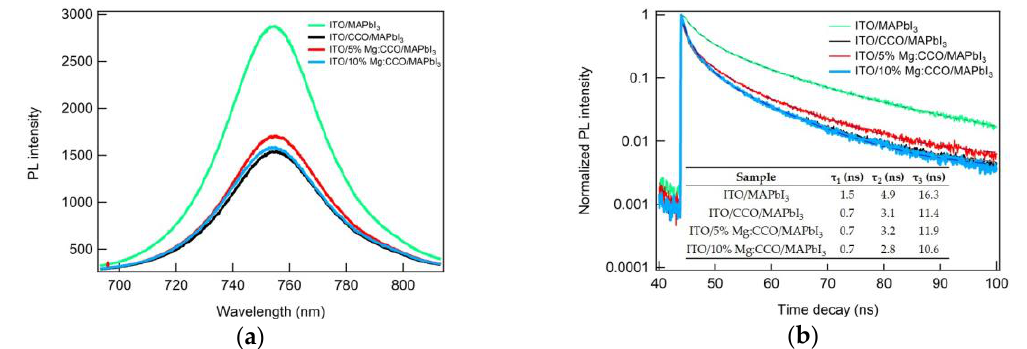
Figure 12. ( a ) Photoluminescence (PL) emission spectra and (b) time-resolved photoluminescence (TRPL) decay for ITO/MAPbI 3 (green), ITO/CCO/MAPbI 3 (black), ITO/5% Mg:CCO/MAPbI 3 (red), and ITO/10% Mg:CCO/MAPbI 3 (blue). In (b), the lines are fits to three exponential decays: dotted green line for ITO/MAPbI 3 , solid grey line for ITO/CCO/MAPbI 3 , dashed brown line for ITO/5% Mg:CCO/MAPbI 3 , and dotted-dashed blue line for ITO/10% Mg:CCO/MAPbI 3 . The inset table in (b) shows the fitted PL lifetimes for all samples.